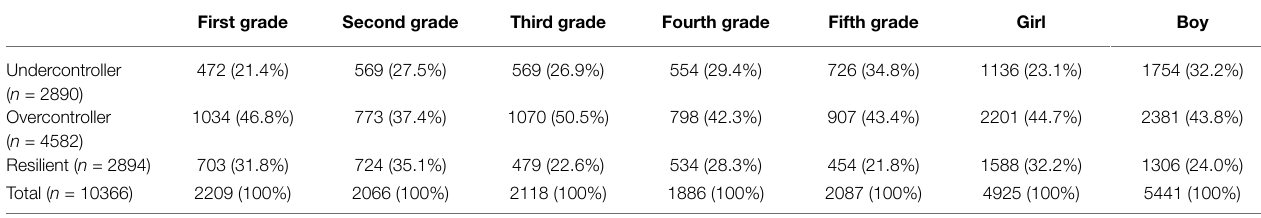
TABLE 4 | The number and ratio of each type of personality in each grade and gender.